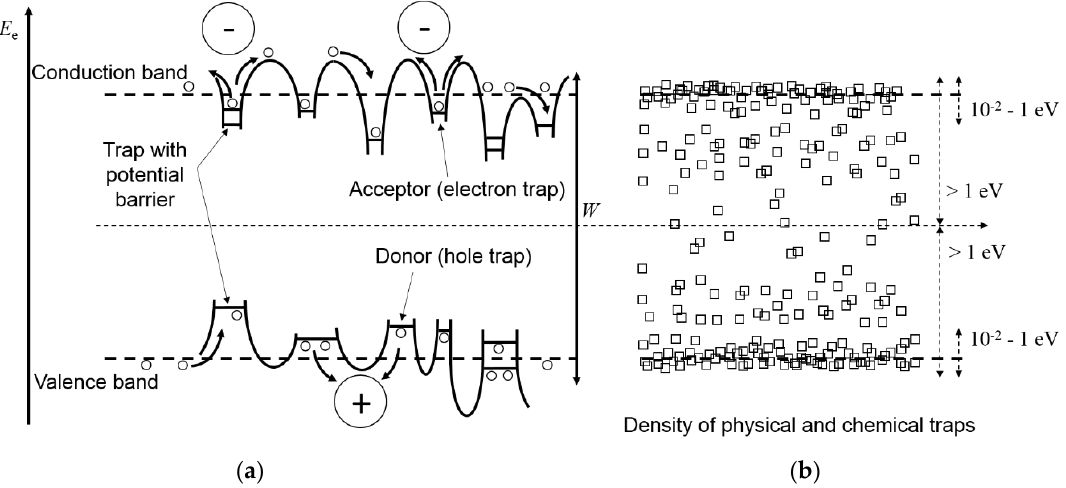
Figure 2. ( a ) Band structure for an insulation material like cross-linked polyethylene (XLPE), where states with different energy levels are formed due to the semicrystalline structure of polyethylene (PE) and impurities within the material. Because of these states, only a mean band gap energy W is defined; ( b ) density of traps as a function of the trap depth. A high density of shallow traps (trap depth 10 −2 – 1 eV) is seen near the conduction band and the valence band. With increasing trap depth and thus distance to the conduction band and the valence band, the trap density is decreasing [17,20,21]. Charges correspond to the conduction mechanism if they are released from traps.